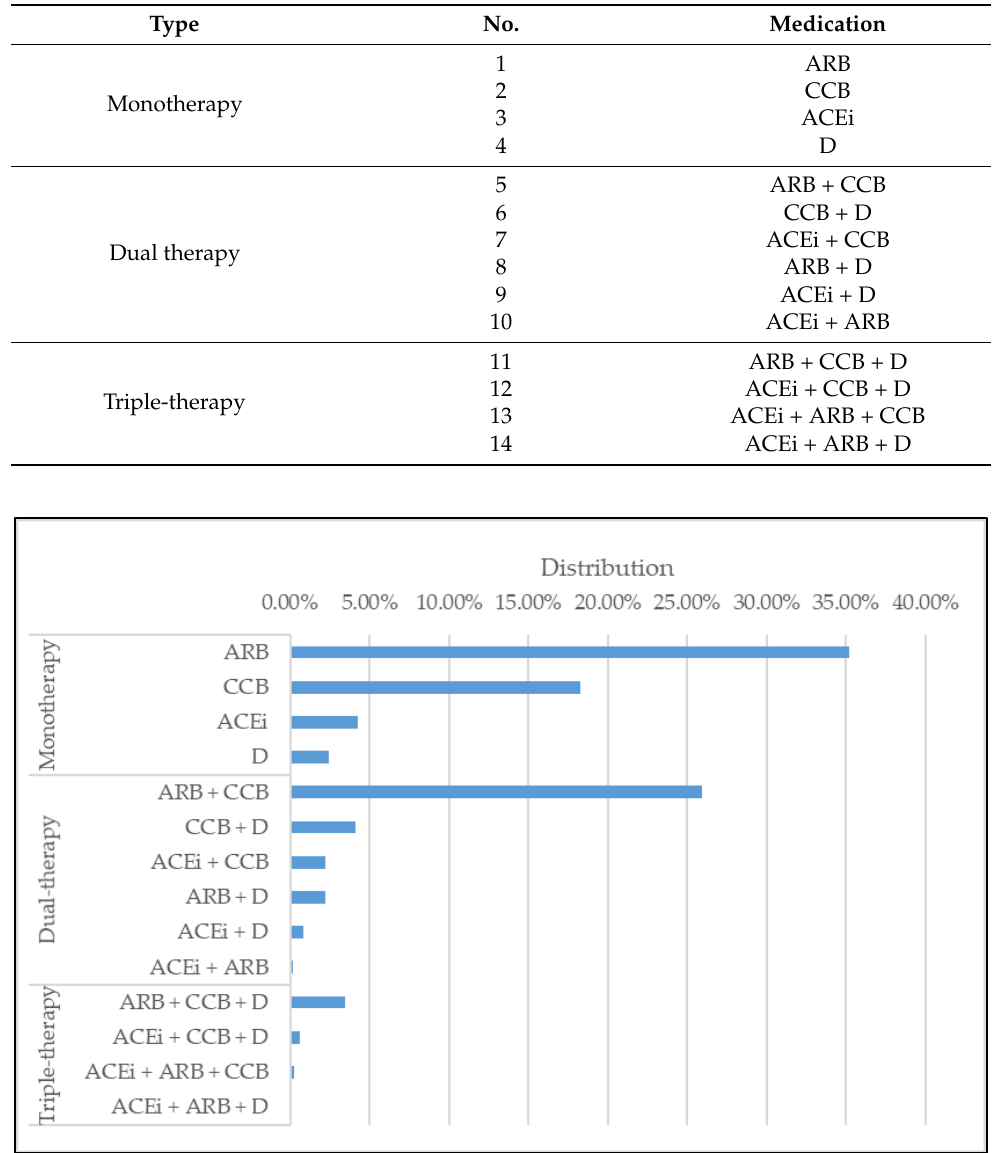
Figure 1. Distribution of actions in database.